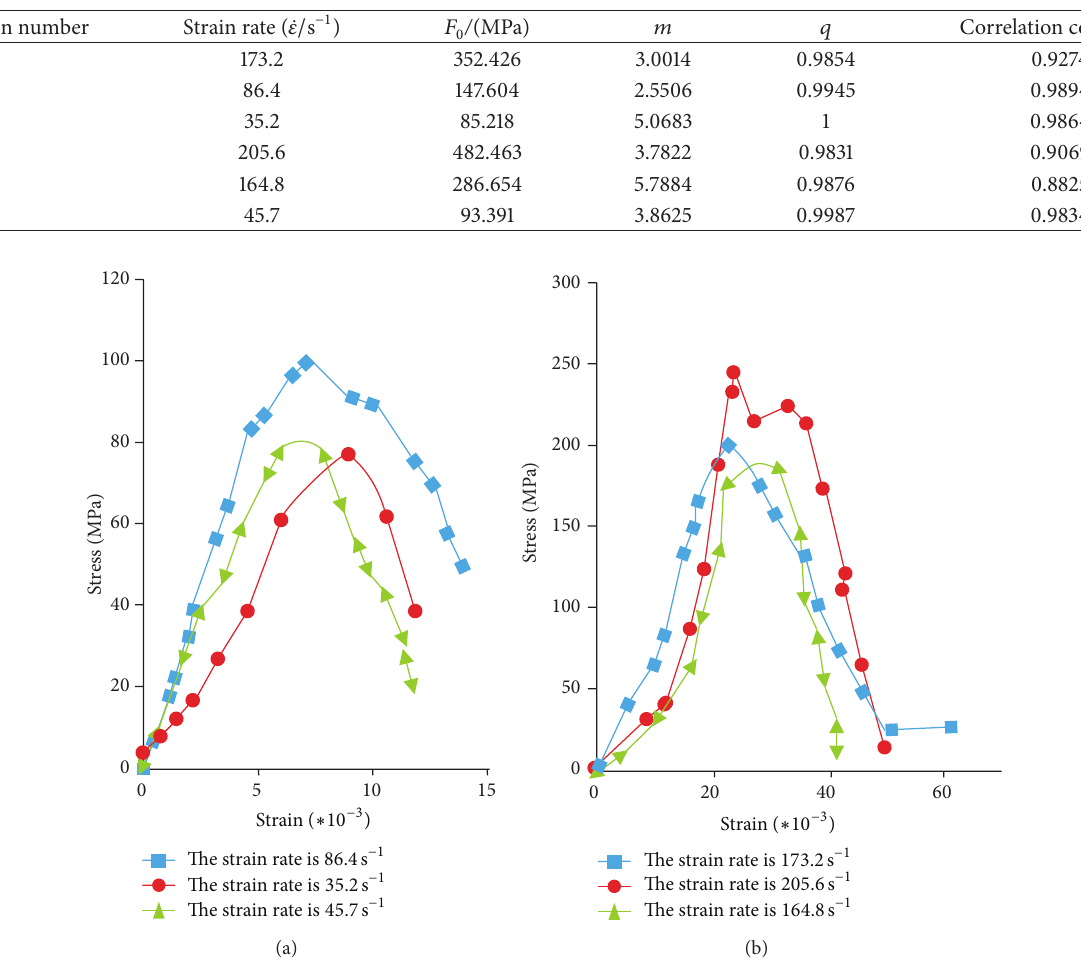
Figure 2: The stress-strain curves under different strain